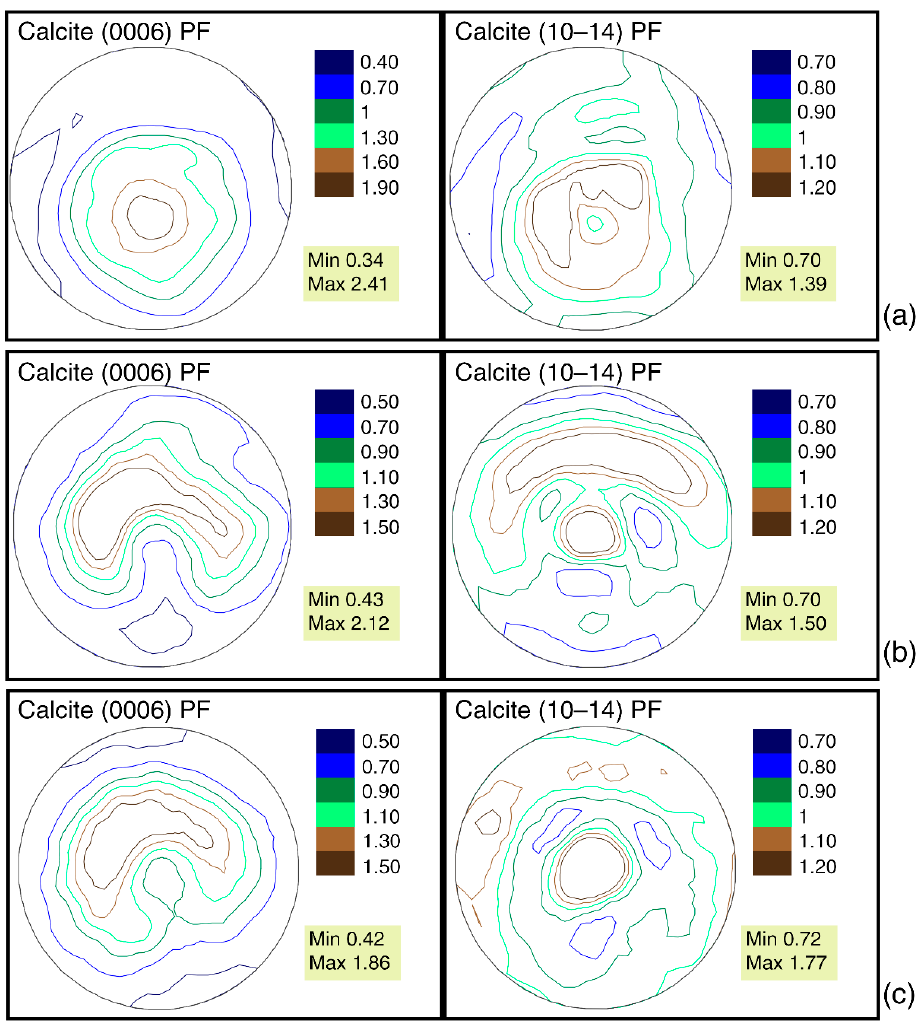
Figure 8. Calcite pole figures of thick-walled valves from fossil bivalves: ( a ) left valve of Pycnodonte mirabilis Rousseau, 1842, Crimea Peninsula, Upper Cretaceous, Maastrichtian; ( b ) right valves of Ostrea edulis Linnaeus, 1758, the coast of the Arabatsky Gulf of the Azov Sea in the town of Shchelkino (Crimea Peninsula), Pleistocene, Karangat deposits; ( c ) right valves of Ostrea edulis Linnaeus, 1758, Taman Peninsula, Chushka Spit, Pleistocene, Karangat